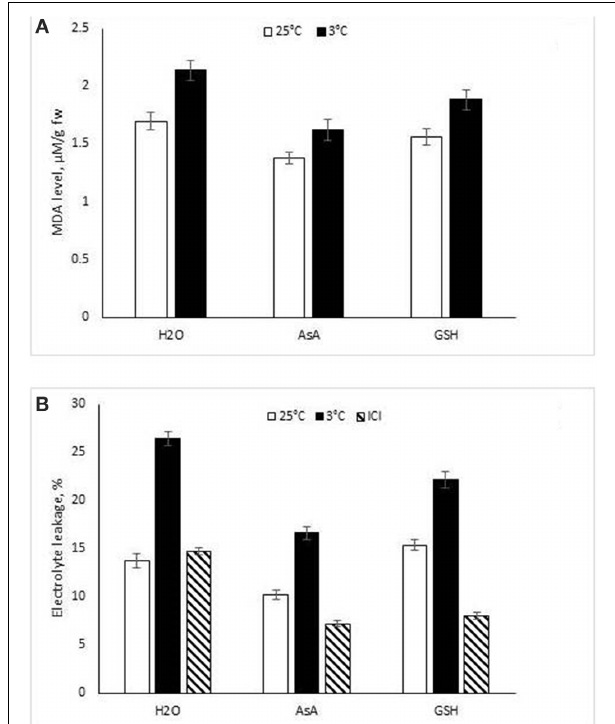
FIGURE 2 | Effect of ascorbic acid (AsA) and glutathione (GSH) concentrations on lipid peroxidation (LPO) intensity (A) and electrolyte leakage (B) in the leaf discs of Cucumis sativus incubated for 4h at 3 and 25 ◦ C